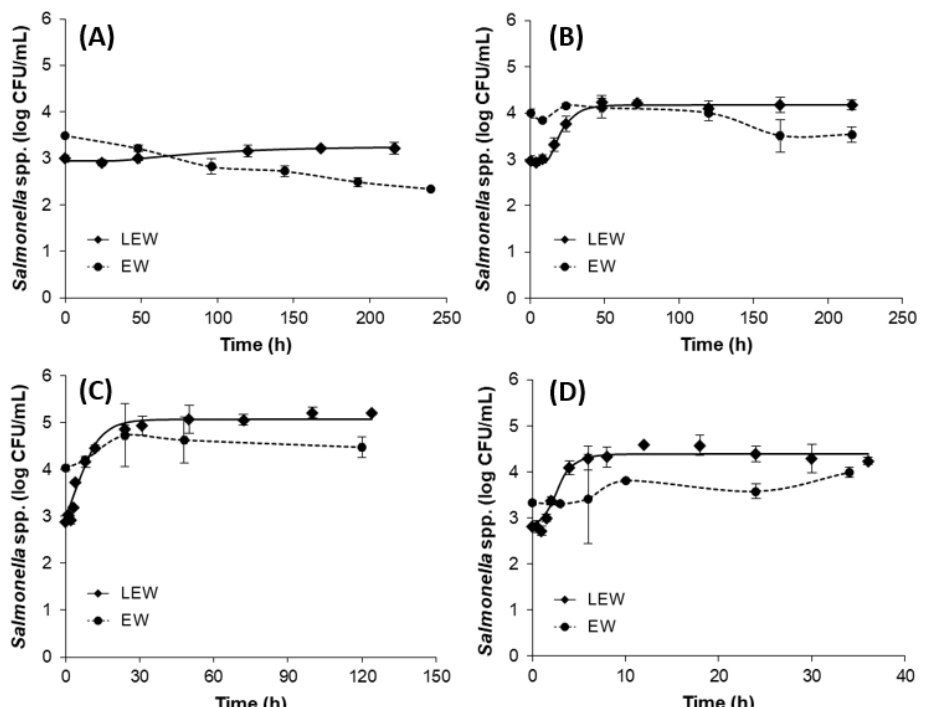
Figure 1. Primary model of the growth of Salmonella spp. in liquid egg whites (LEW) and growth curve in egg whites (EW). ( A ) 10 °C; ( B ) 15 °C; ( C ) 25 °C; ( D ) 37 °C. ♦ : observed value for LEW, curve in egg whites (EW). ( A ) 10 ◦ C; ( B ) 15 ◦ C; ( C ) 25 ◦ C; ( D ) 37 ◦ C. (cid:7) : observed value for LEW, solid solid line: fitted line of primary model for LEW, ● : observed value for EW, dashed line: growth or line: fitted line of primary model for LEW, • : observed value for EW, dashed line: growth or survival survival curve for EW. curve for